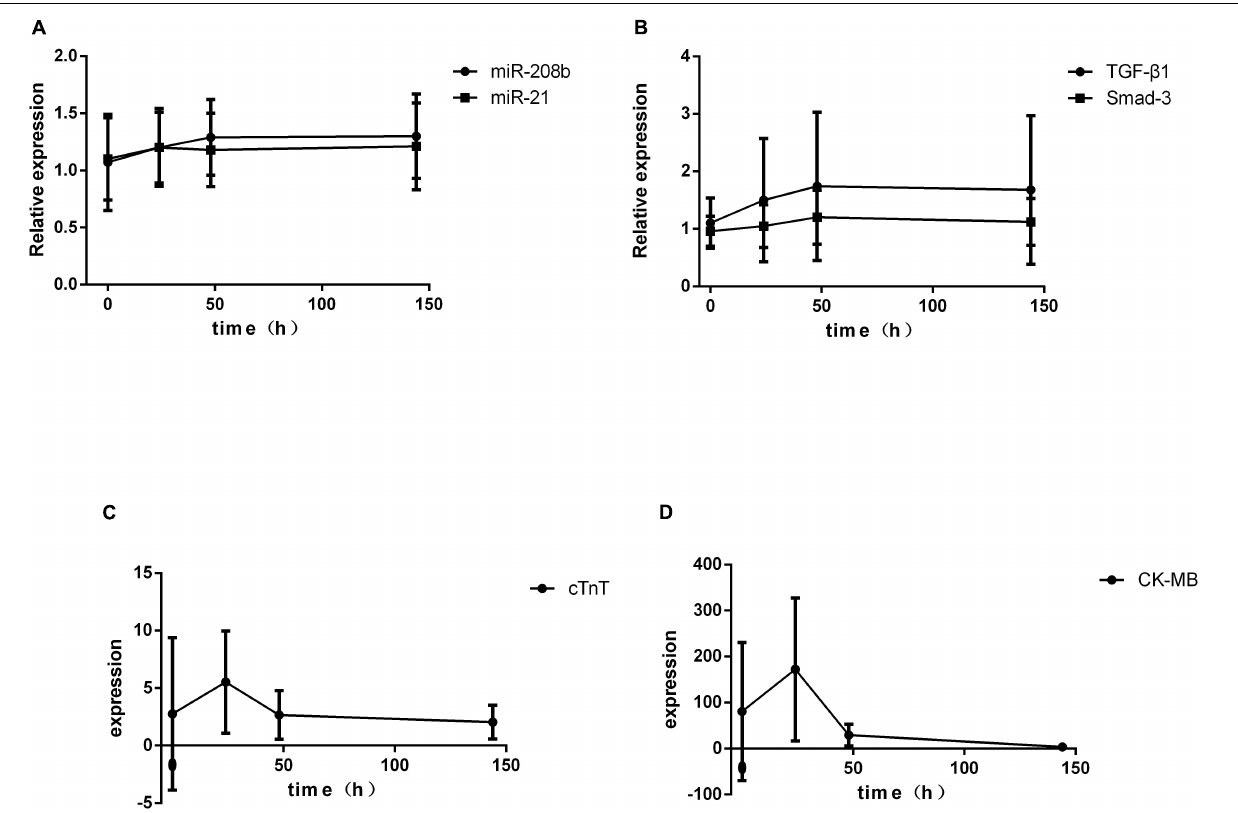
FIGURE 1 | Temporal changes in serum indices in AMI patients. (A) The expression levels of miR-208b and miR-21 change with time; (B) the expression levels of TGF- β 1 and Smad-3 change with time; (C) the expression level of cTnT changes with time; (D) the expression level of CK-MB changes with time. CK-MB, creatine kinase isoenzyme; cTnT, cardiac calcium protein T; TGF- β 1, transforming growth factor- β 1.